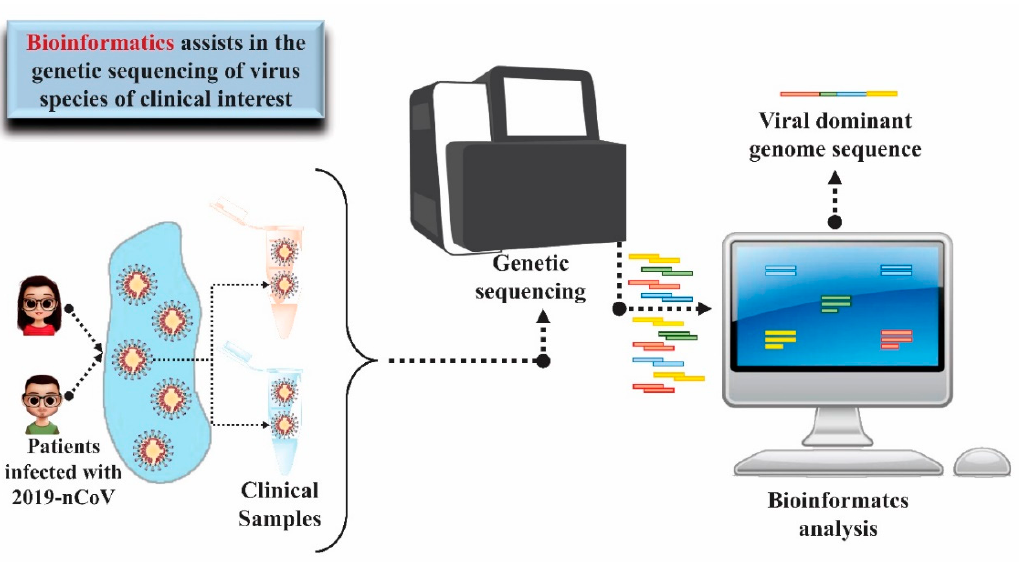
Figure 6. Bioinformatics as technologies applied to health as allies to coping with the disease: Bioinformatics is a technology that assists researchers in coping with diseases by investigating genetic sequencing and seeking structural models of potential molecular targets present in SARS-CoV-2. Note: This image was developed using the CorelDraw software (2017 Corel Corporation ID